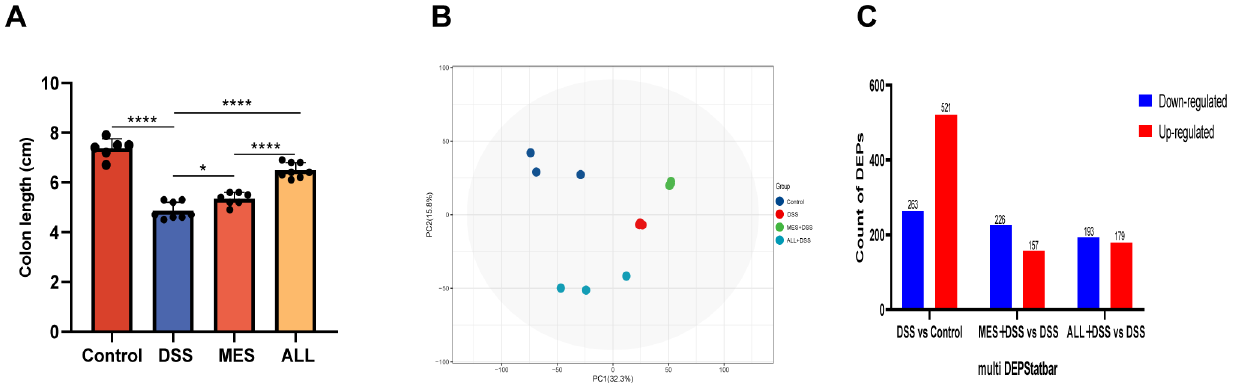
Figure 4. The effects of difference treatments. ( A ) ALL improved the colon length of DSS-induced colitis in C57BL/6 mice. * p < 0.05 and **** p < 0.0001. ( B ) The PCA score was different in each group. ( C ) Up- and downregulated DEPs of each comparison group. Each point in the graph represents a sample, and the distance between the points reflects the sample similarity. Only proteins with a fold change ≥ 1.5 and a p -value < 0.05 were considered for DEPs.